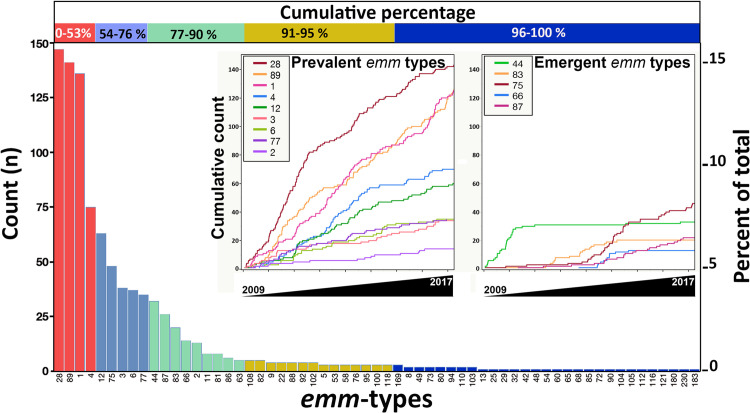
GAS emm types distribution and dynamic profiles.The distribution of each emm type was shown in the main histogram. Cumulative percentages of all the GAS isolated were reported at the top of the figure. Cumulative counts from 2009 to 2017 for “Prevalent” and “Emergent” emm types were presented independently. “Prevalent” emm types included 9 genotypes (emm1, 12, 3, 6, 4 28, 89, 77 and 2), and “Emergent” emm types includes 5 different genotypes that emerged successively in the following order: emm44 (already present in 2009 and sudden decrease of its occurrence in 2010, quarter (Q)4); emm83 (2011; Q2), emm75 (2013; Q1), emm66 (2013; Q2), and emm87 (2013; Q3).